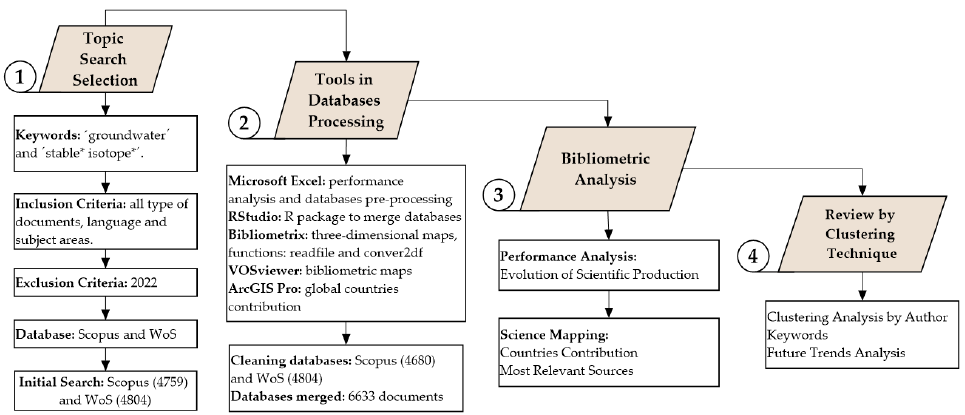
Figure 1. Methodological scheme applied to GSI.